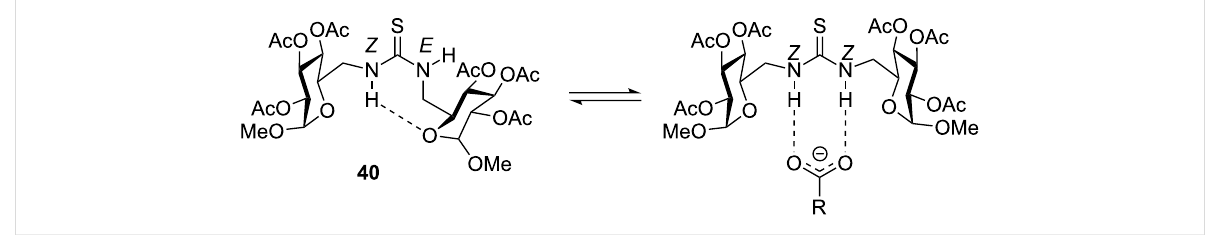
Figure 16: Rotameric equilibrium shift of 40 by formation of a bidentate hydrogen bond.